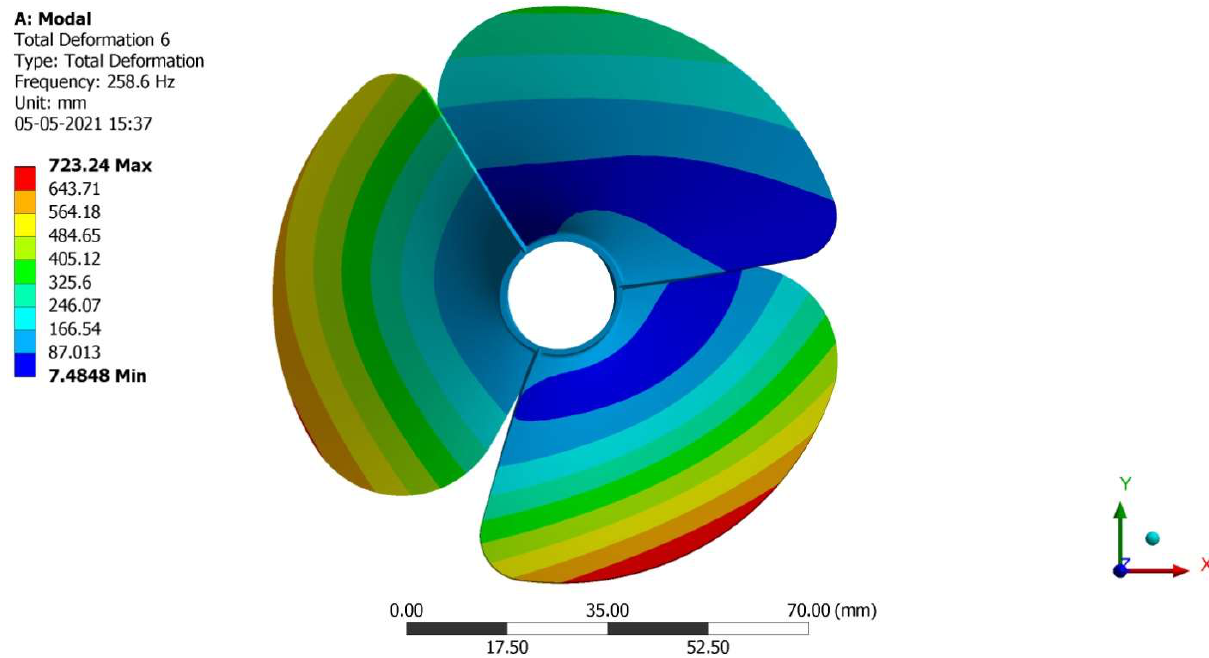
Figure 47. Sixth mode shape outcome of KFRP-UD-49 based composite.